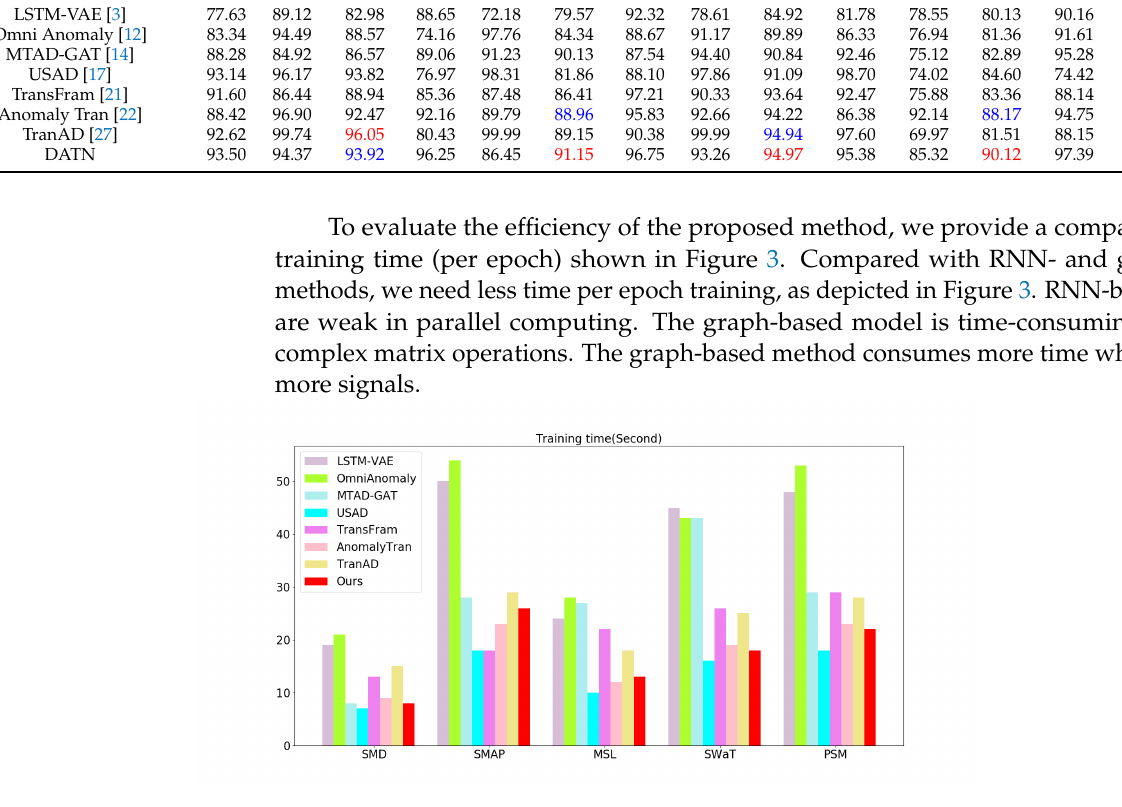
Figure 3. Efficiency comparison of the baseline